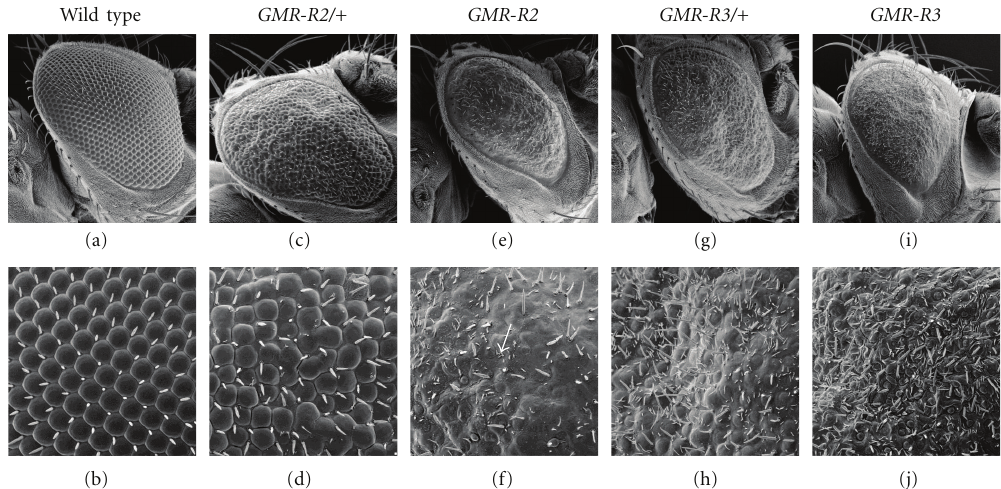
Figure 2: The GMR-R phenotype. SEMs of wild-type (a, b), GMR-R2 heterozygous (c, d), GMR-R2 homozygous (e, f), GMR-R3 heterozygous (g, h), and GMR-R3 homozygous (i, j) eyes are presented. The images are presented as 500x (top panels) and 2000x (bottom panels). Arrow points to hair-like